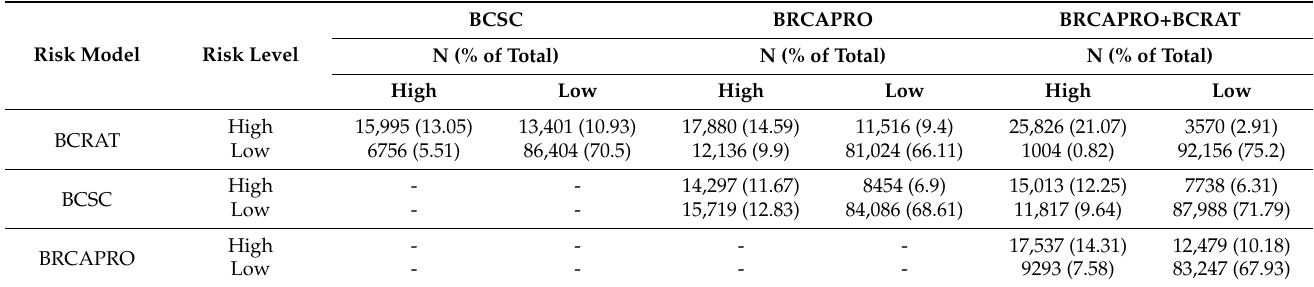
Table 6. Concordance between 5-year high-risk estimates across